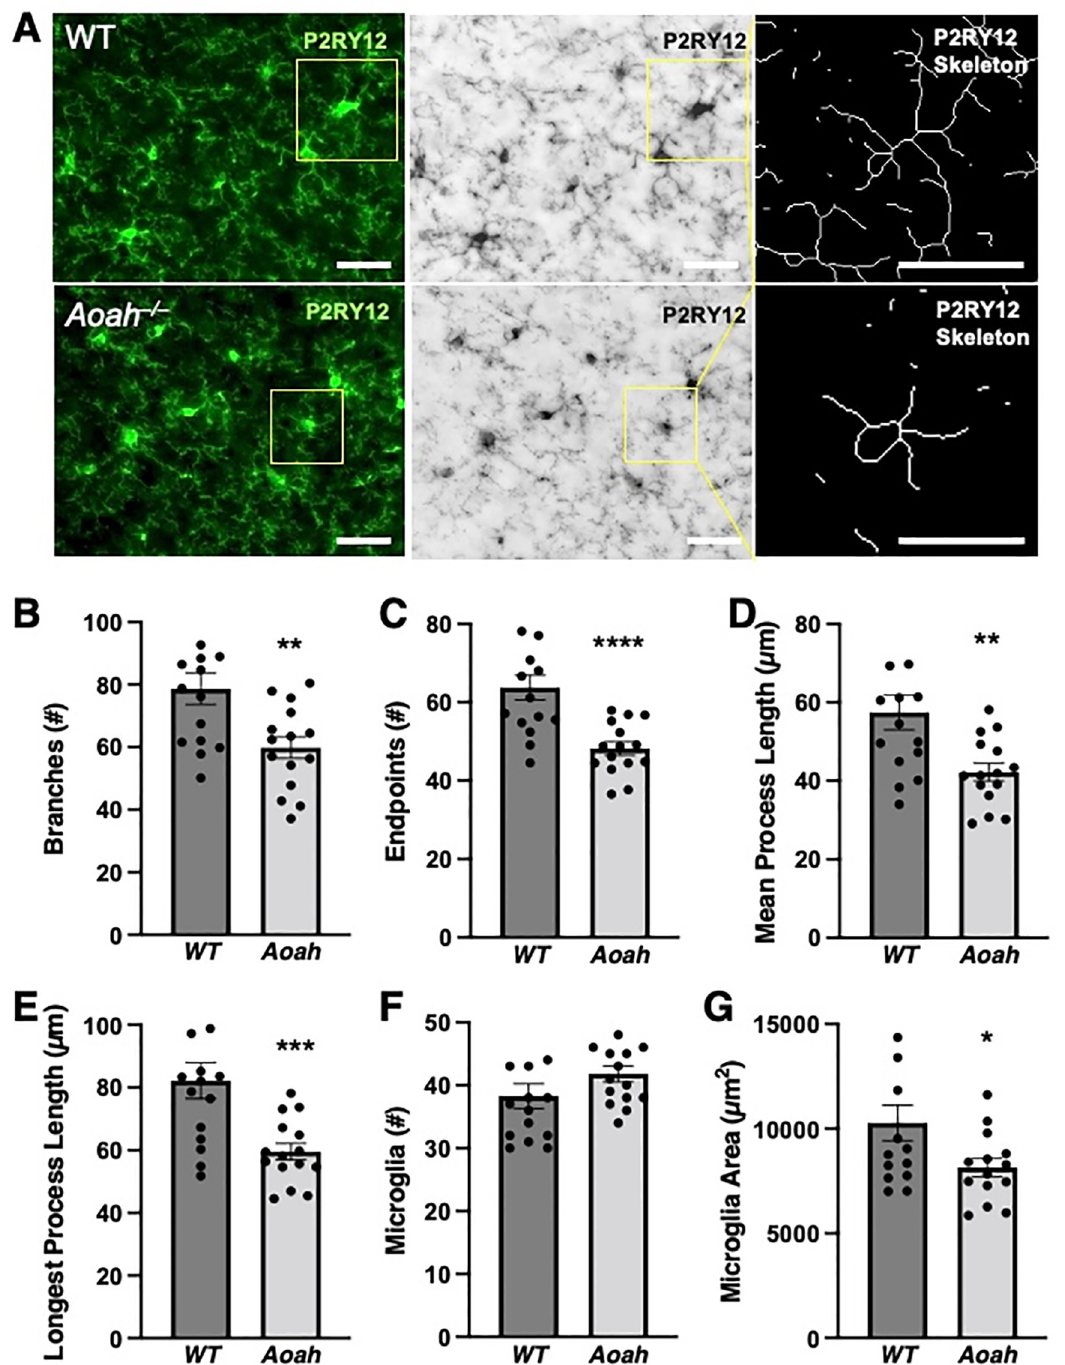
Fig 4. Microglia in AOAH-deficient prefrontal cortex exhibit an activated phenotype. A : Example of photomicrographs used for skeletal analyses obtained from the prefrontal cortex as defined in Fig 2A. Left column shows immunostaining of P2RY12 (green) in cortical microglial cells in WT (top) and AOAH-deficient (bottom) mice. DAPI staining nuclei shown in blue (scale bar: 30 μ m). Middle column shows 8-bit grayscale images (scale bar: 30 μ m). Right column shows example of skeletonized microglia used for quantification (scale bar: 30 μ m). All z-stacks were taken with a 20X objective. B-G : Quantitative analyses of skeletonized microglia in the prefrontal cortex of female wild type and Aoah –/– mice (Student’s t test, two tailed. Data represented as average ± SEM; n = 15 fields from 3 mice). Aoah –/– mice exhibit significantly fewer branches ( B , P = 0.0021), endpoints ( C , P < 0.001), mean process length ( D , P = 0022), longest process ( E , P = 0.0004), and microglia area ( G , P = 0.0437). Microglia counts ( F , P-0.192) were not significantly